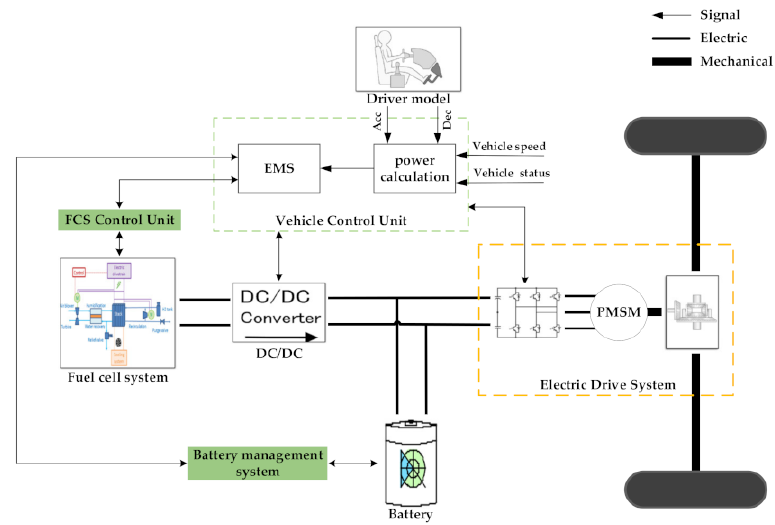
Figure 1. Structure of the fuel cell hybrid electric vehicle powertrain system.